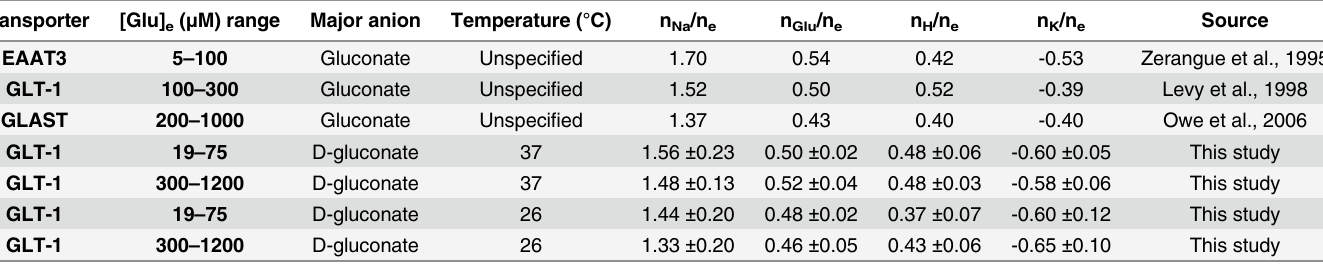
[Glu] e,1 and [Glu] e,2 are two glutamate concentrations which were used to determine number of glutamate molecules transported per one elementary charge (e + ) in an appropriate study. Data are shown as mean ±